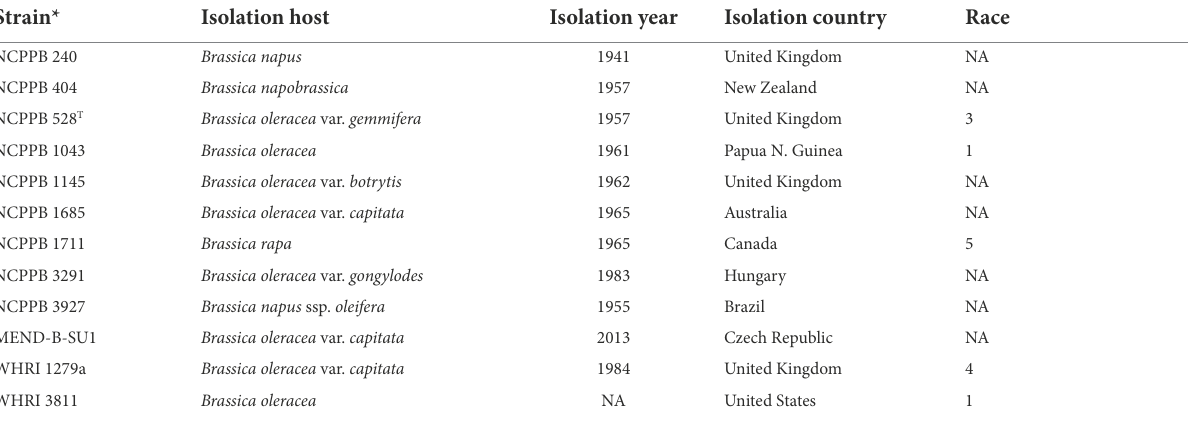
TABLE 1 Xanthomonas campestris pv. campestris strains used in the